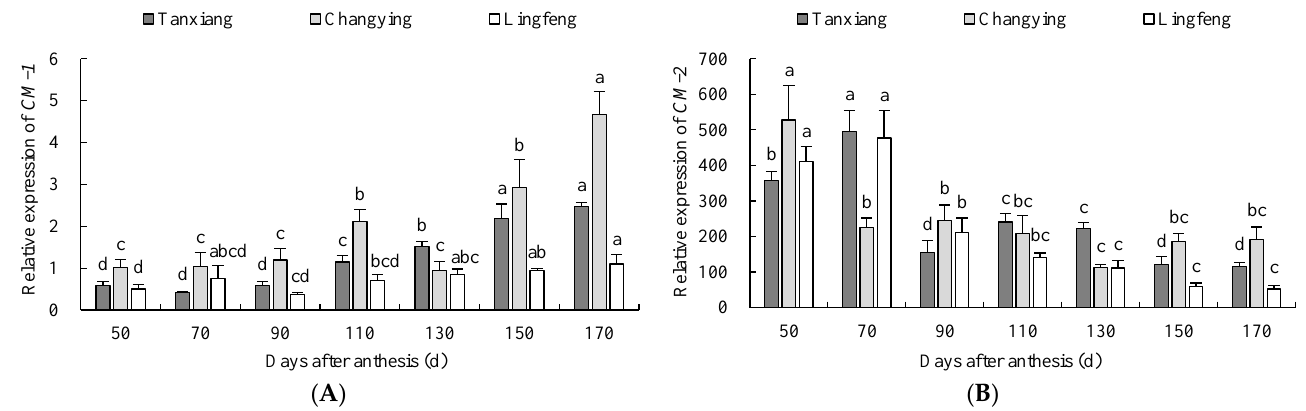
Figure 7. Expression of CMs in Chinese olive fruit at different developmental stages. Bars represent the standard deviation for three biological replicates. Different letters indicate significant differences among different stages of the same cultivars ( p < 0.05). ( A ) CM-1 and ( B ) CM-2 .